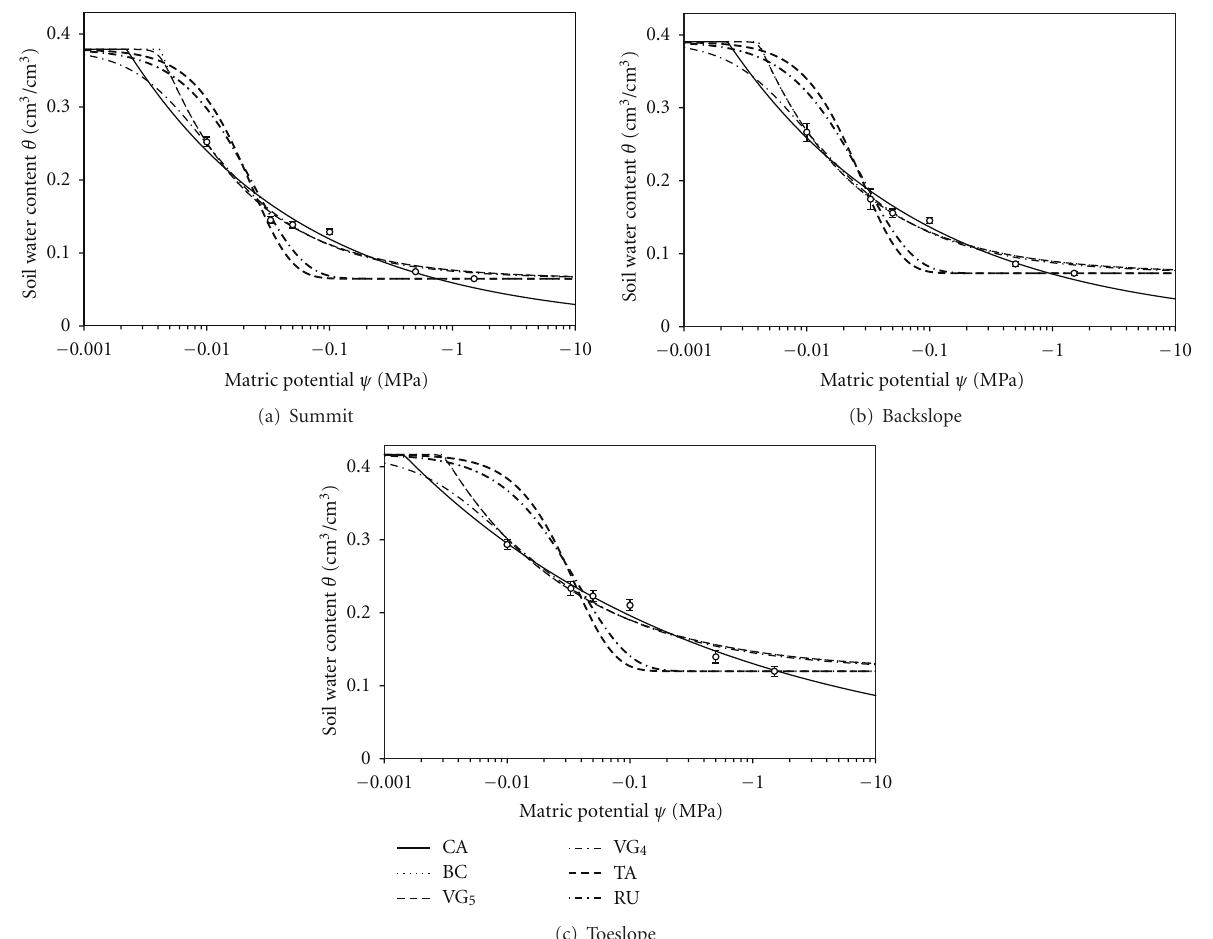
Figure 1: Fitted SWRC for soil water contents ( θ ) at soil matric potentials ( ψ ) for the (a) summit, (b) backslope, and (c) toeslope positions averaged across two hillslopes using the Campbell (CA) model with absent θ r parameter, and Brooks-Corey (BC), five- and four-parameter van Genuchten (VG 5 and VG 4 ), Tani (TA), and Russo (RU) models with θ r constrained to measured values at − 1.5 MPa. Error bars are SE for six water retention